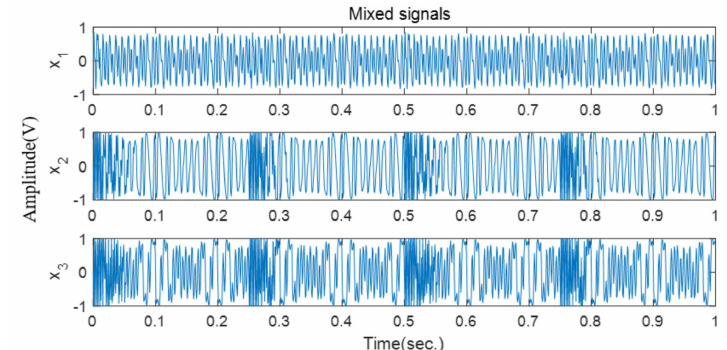
Figure 8. Time–domain waveform of the nonlinear mixed signals.